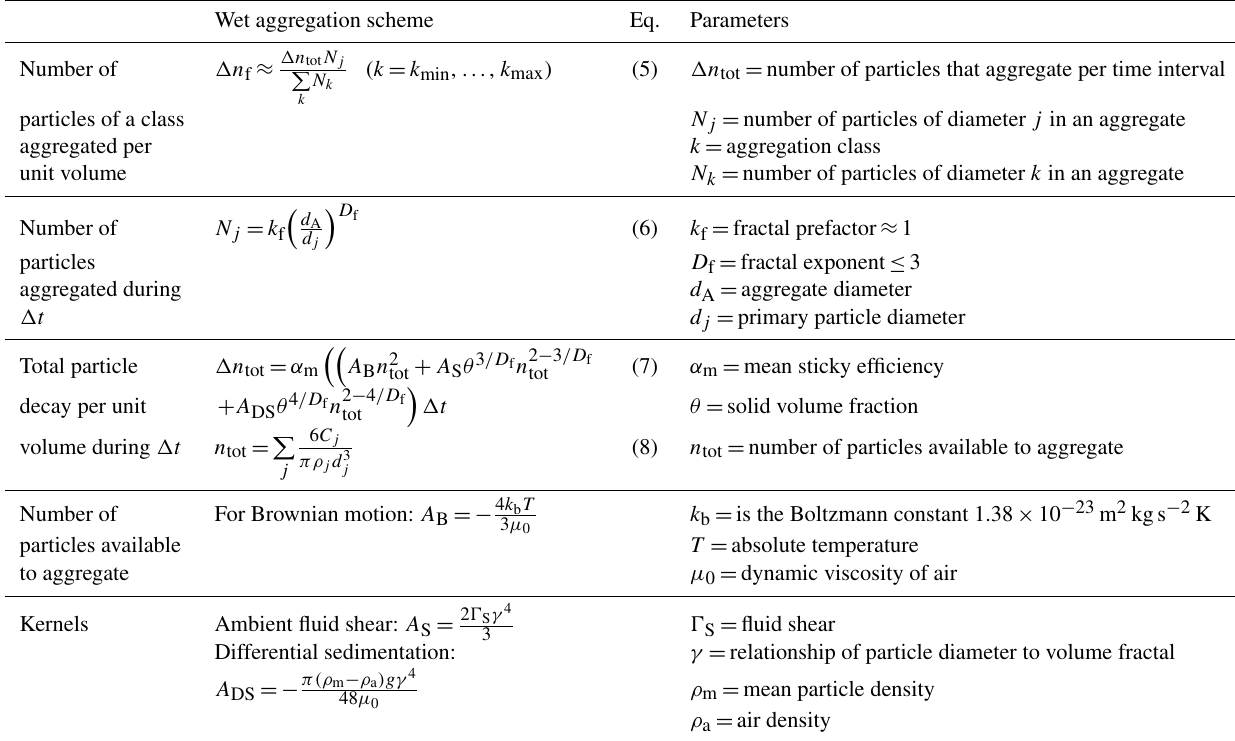
Table 4. Governing equations for NMMB-MONARCH-ASH wet aggregation model. Wet aggregation